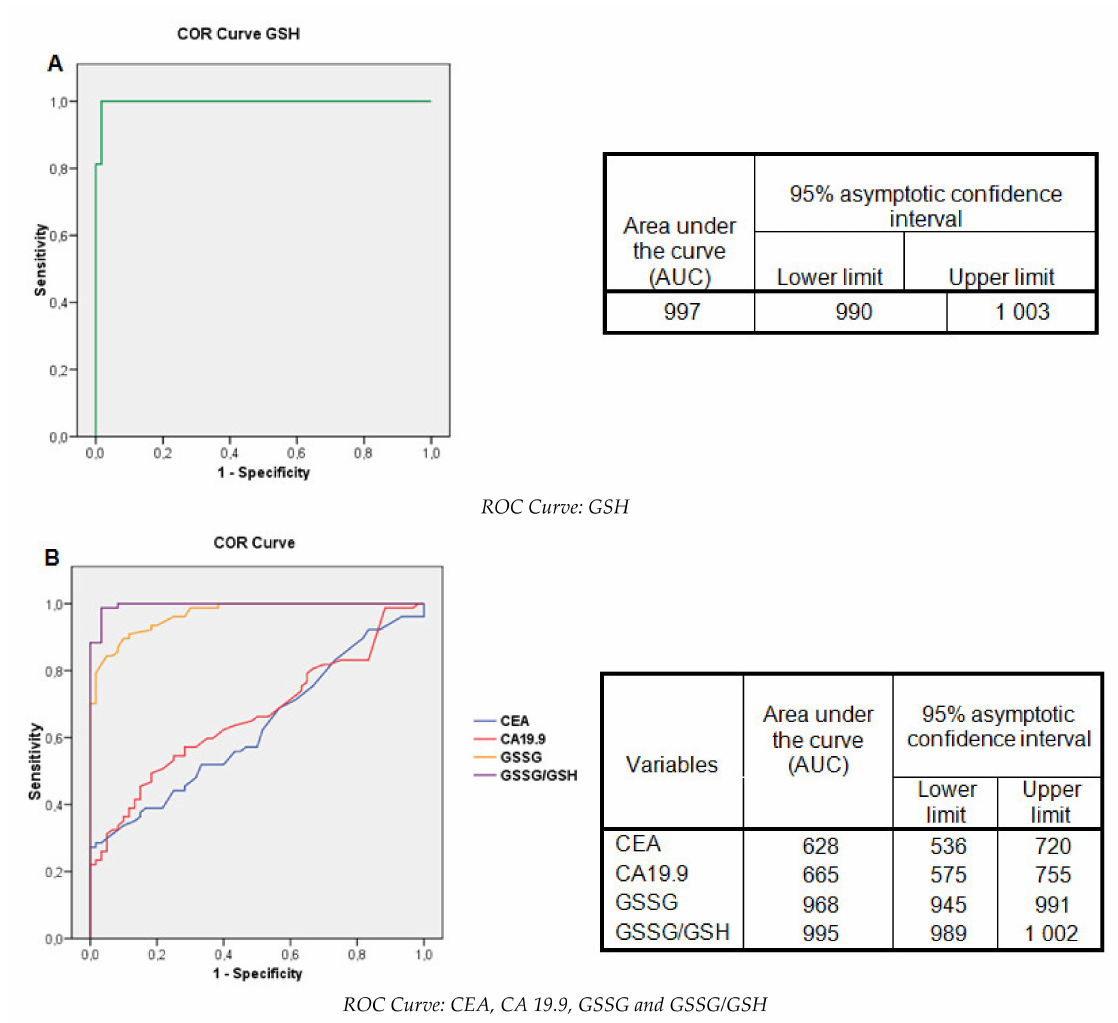
Figure 5. Receiver operating characteristic (ROC) curves for the analyzed markers. ( A ) Reduced glutathione (GSH); ( B ): CEA, CA 19.9, oxidized glutathione (GSSG), and the GSSG/GSH